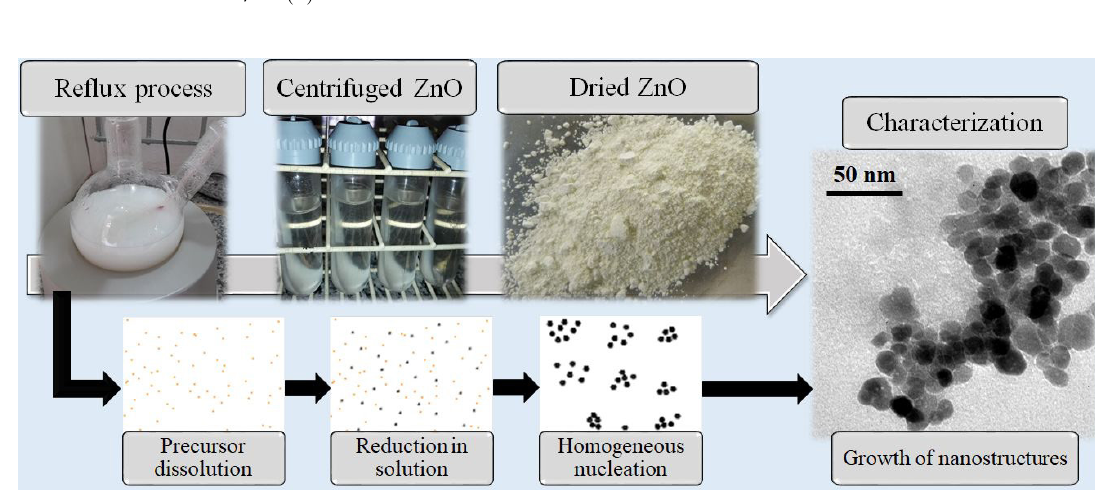
Figure 1. Simplified process for obtaining nanostructured zinc oxide in polyol medium.